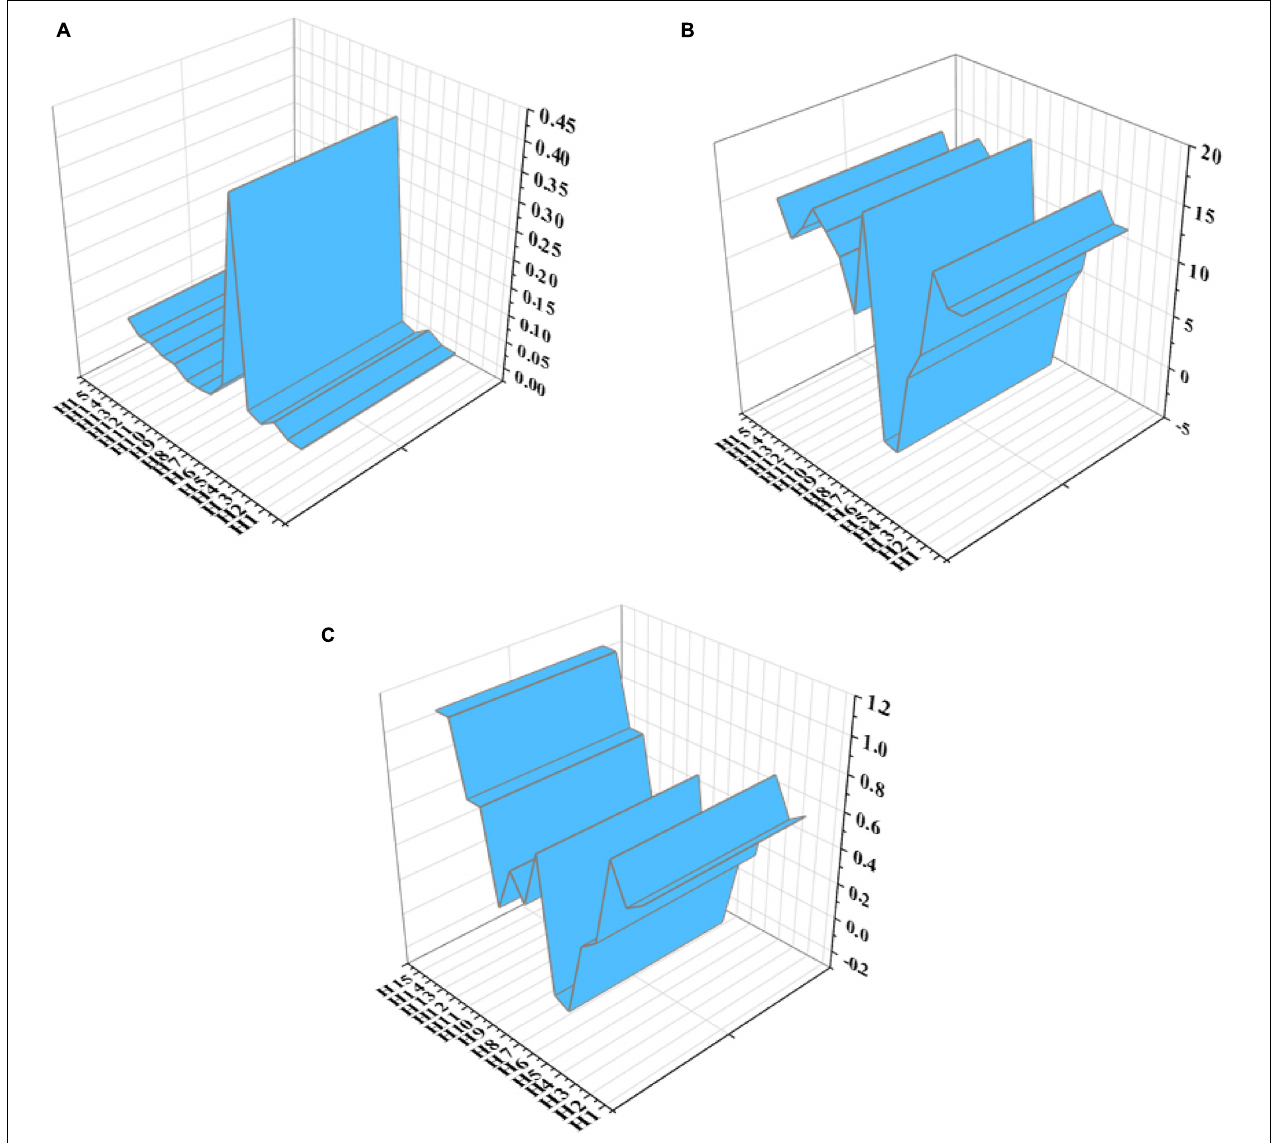
FIGURE 11 | Parameter test value of the structural model. (A) Test value of S.E. (B) Test value of C.R. (C) Test value of β ).